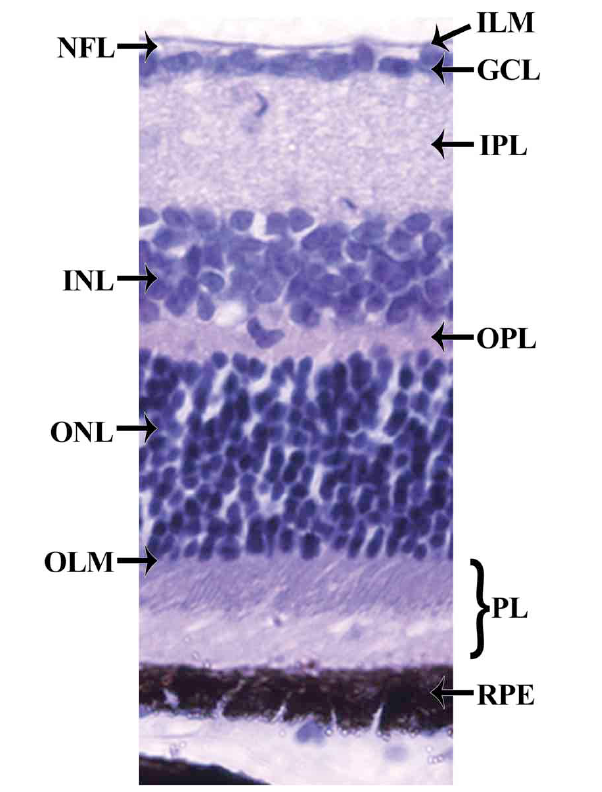
FIGURE 2 | Histology of the retina. The retina can be divided into 10 layers including (1) the inner limiting membrane (ILM); (2) the nerve fiber layer (NFL); (3) the ganglion cell layer (GCL); (4) the inner plexiform layer (IPL); (5) the inner nuclear layer (INL); (6) the outer plexiform layer (OPL); (7) the outer nuclear layer (ONL); (8) the outer limiting membrane (OLM); (9) the photoreceptor layer (PL), and (10) the retinal pigmented epithelium (RPE)